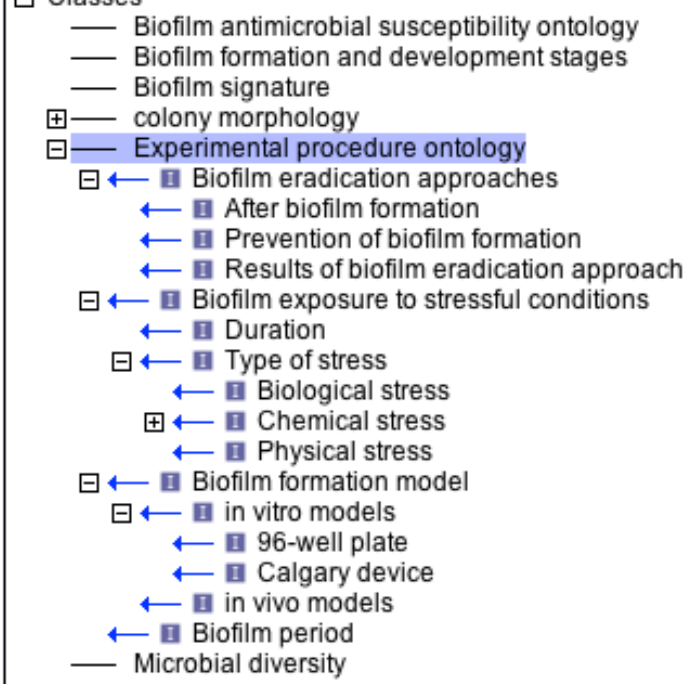
Fig. 3: General tree view of EPO within BSO